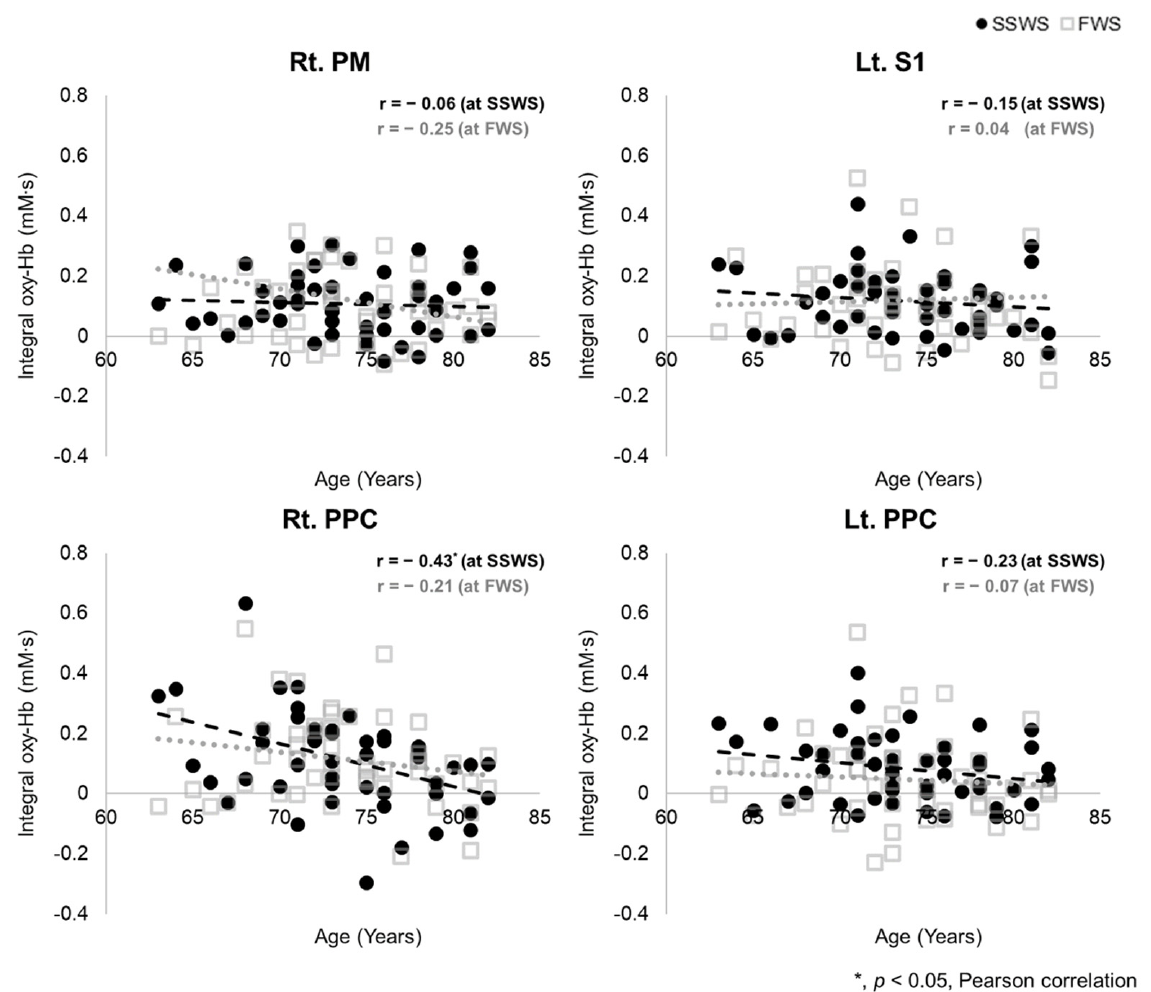
Figure 4. Association between age and regional oxyHb values during dual-task walking. The black circle represents self-selected walking speed (SSWS), and the gray square represents fast walking speed (FWS). In the SSWS, the integral value of oxyHb in the right PPC was negatively associated with age. There was no significant correlation in other ROIs such as the right PM, left S1, or left PPC. oxyHb, oxyhemoglobin; PM, pre-motor area; S1, primary somatosensory motor cortex; PPC, posterior parietal cortex; Rt., right; Lt., left.